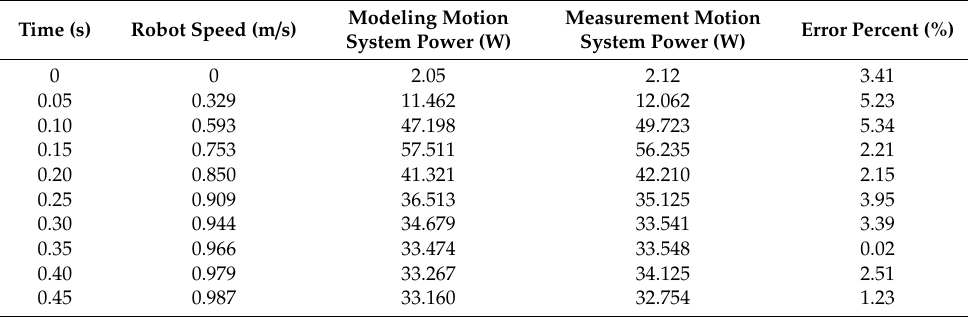
Table 2. Motion power comparison between modeling and